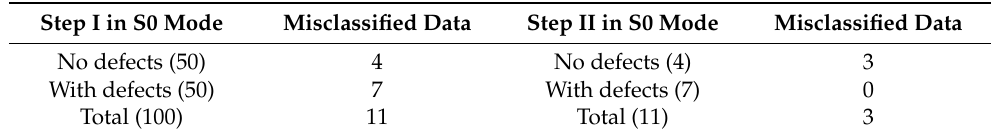
Table 4. Classification results of the newly developed LDA model for classifying the defects by validation